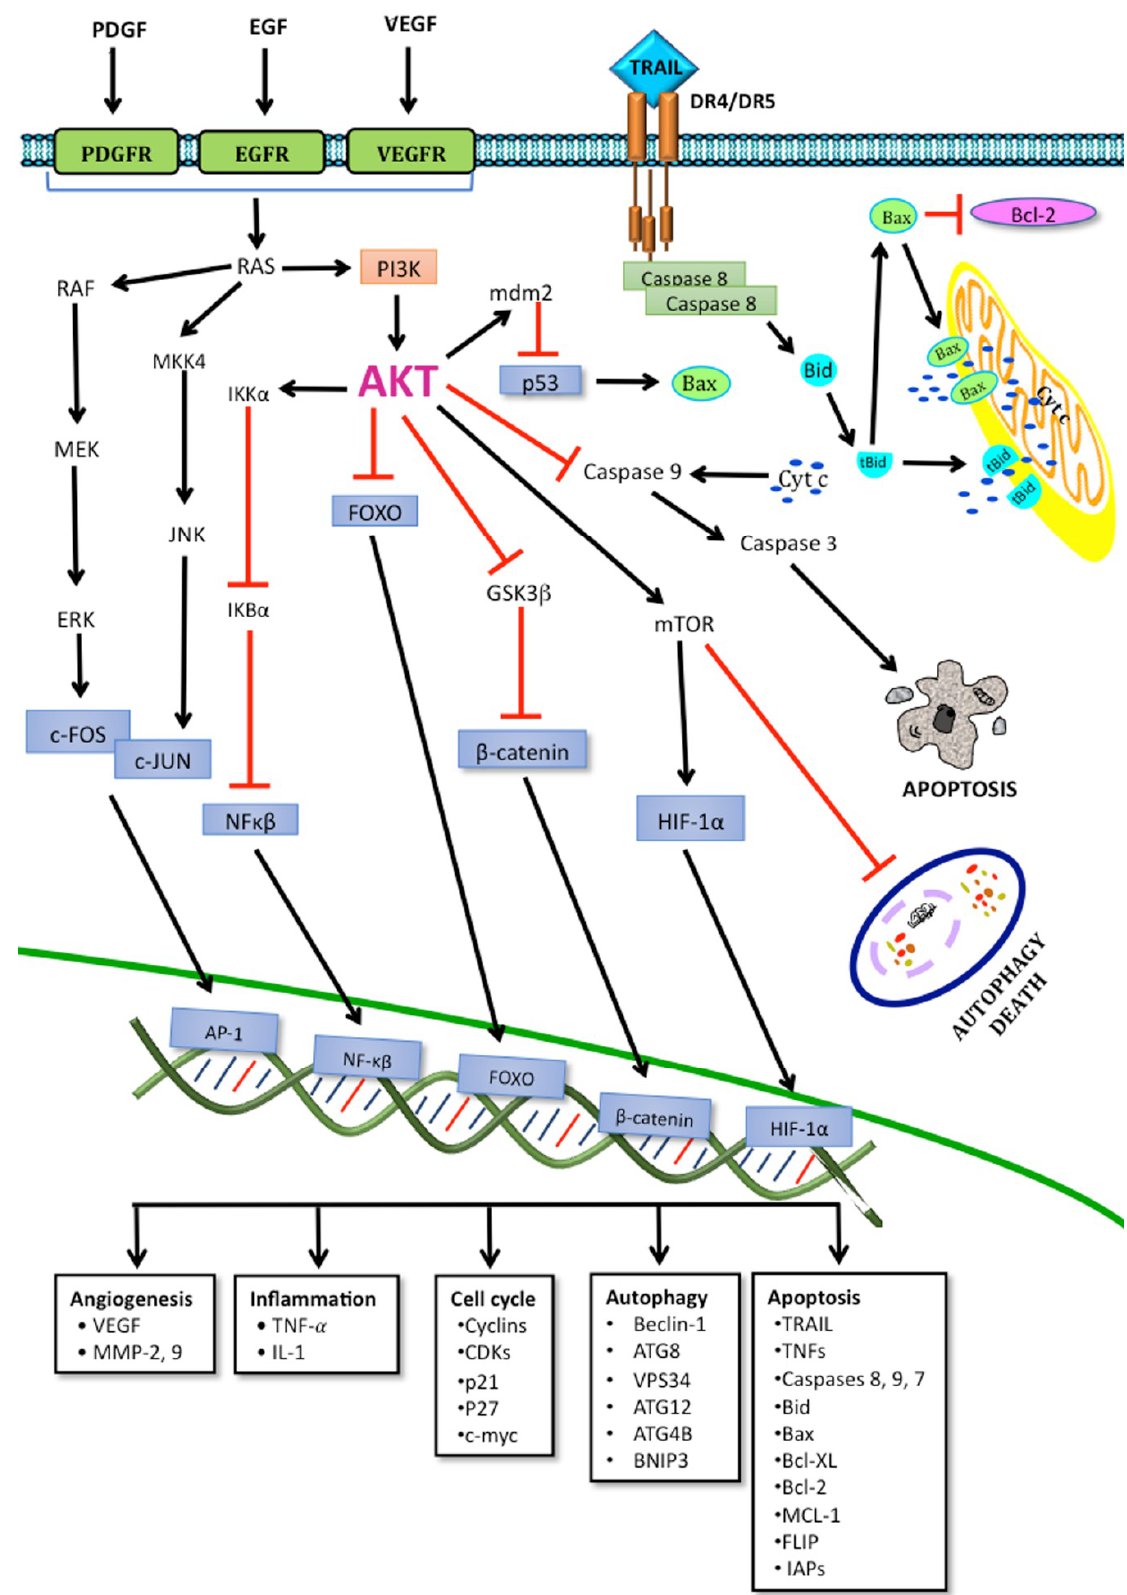
Figure 1. PDGFR-, EGFR-, and VEGFR-mediated signal transduction pathways that are overactivated in glioblastoma. PDGFR (platelet-derived growth factor receptor), EGFR (epidermal growth factor receptor), and VEGFR (vascular endothelial growth factor receptor) are activated at the cell surface by its ligands during tumorigenesis. Activation of these receptors induces several downstream signaling pathways. Among these pathways are the RAS-RAF-MAPK (including ERK, JNK, and p38) 95